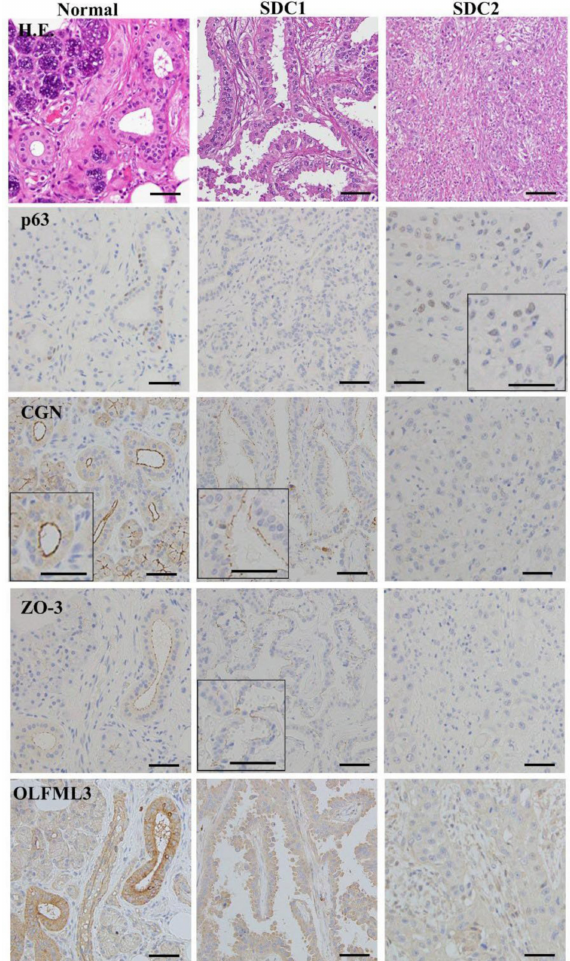
Figure 7. Images of H.E. and immunohistochemical staining of p63, CGN, ZO-3, and OLFML3 in tissues of human salivary duct adenocarcinoma patients (SDC1, SDC2). Scale bar: 200 µ